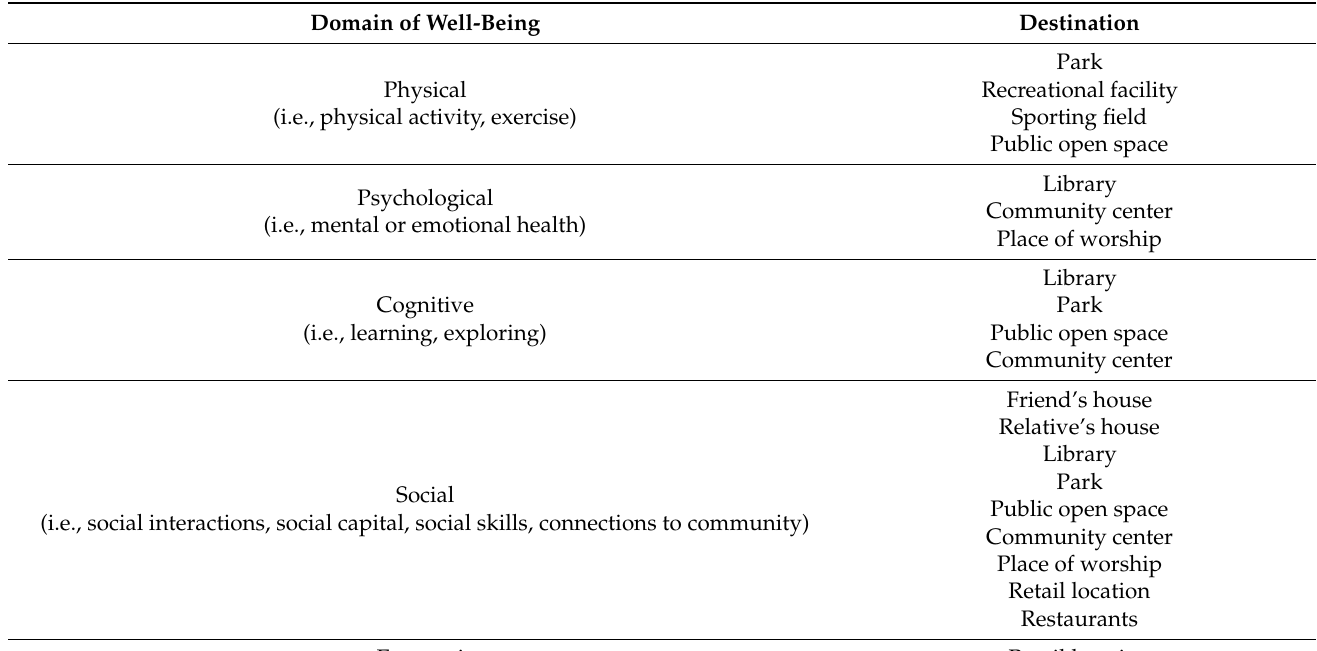
Table 3. Popular non-school destinations accessed by children categorized by domain of well-being based on the work of Waygood et al.